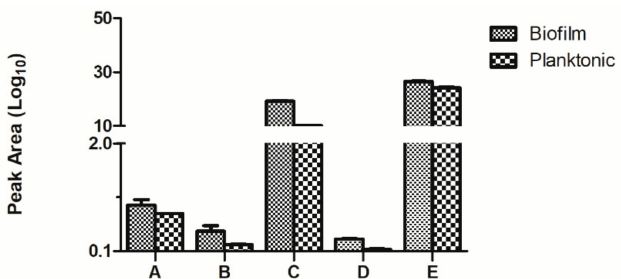
Figure 7. Comparison of the multiple reaction monitoring (MRM) results of the di ff erential proteins in the planktonic and biofilm states of Aeromonas veronii TH0426 (A: biopolymer transporter TonB. B: glycerol-3-phosphate dehydrogenase. C: nucleoside diphosphate kinase. D: hypothetical protein AO720_15660. E: Porin).